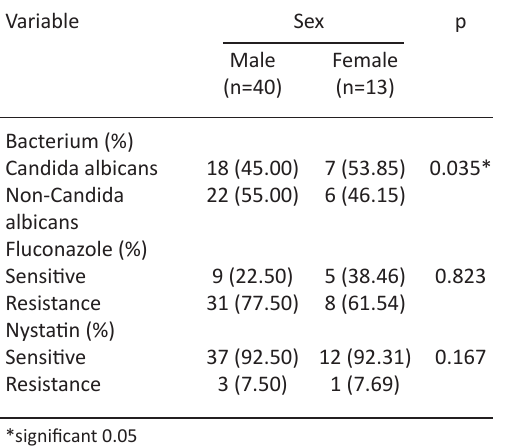
Table 3. Comparison of fluconazole and nystatin Table 2. Comparison of culture results on male